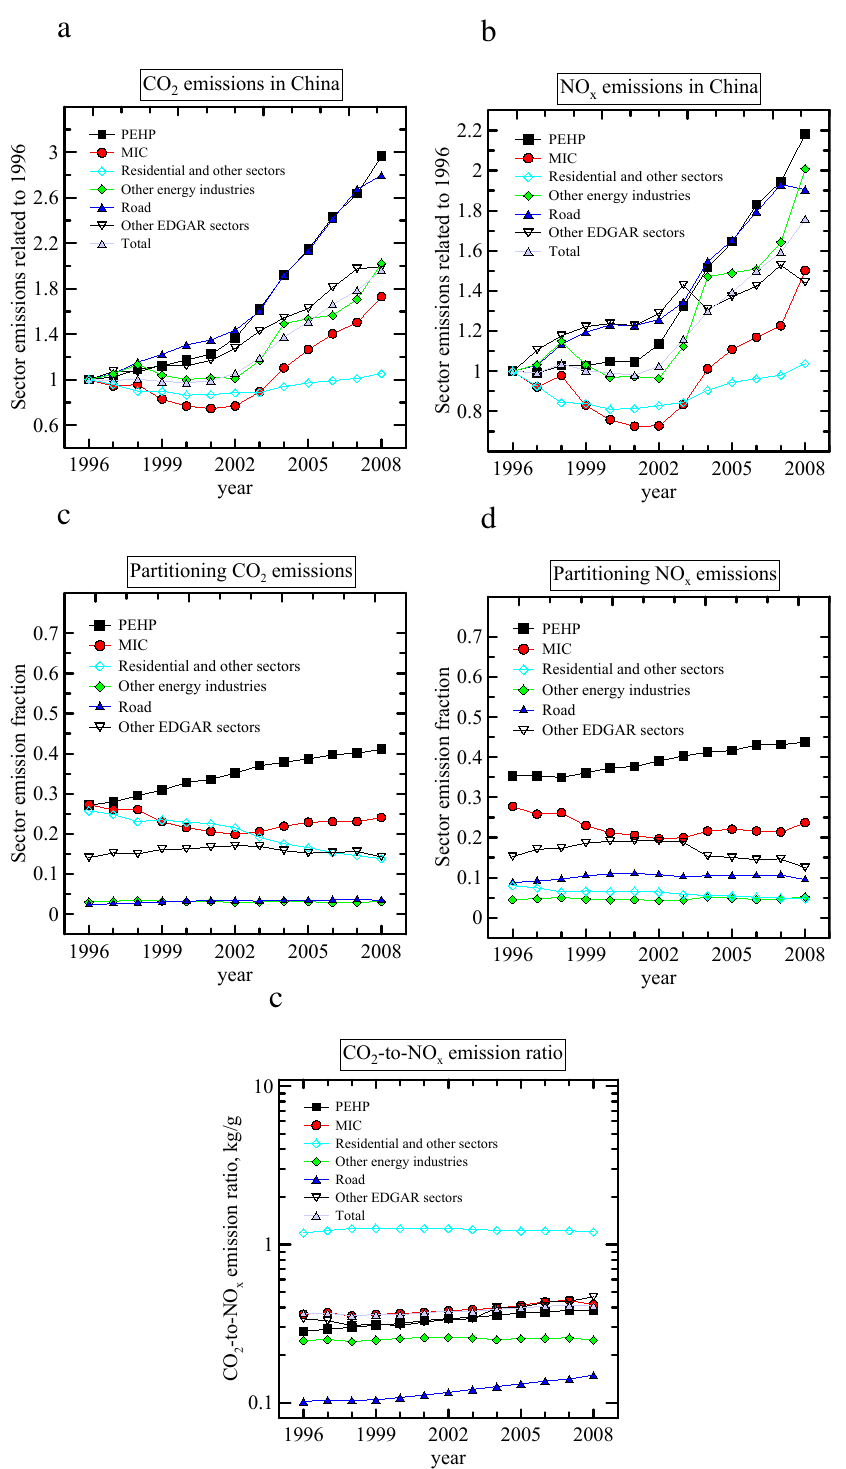
Fig. 8. The annual (a) CO 2 and (b) NO x emissions from different anthropogenic emission sectors in China, (c, d) their partitioning among the emissions sectors according to the EDGAR v4.2 inventory, and (e) the CO 2 -to-NO x emission ratio (analogous to the NO x -to-CO 2 emission conversion factor shown in Fig. 2) according to the EDGAR v4.2 inventory. The emission data are normalized to the values from 1996. PEHP: public electricity and heat production; MIC: manufacturing industries and